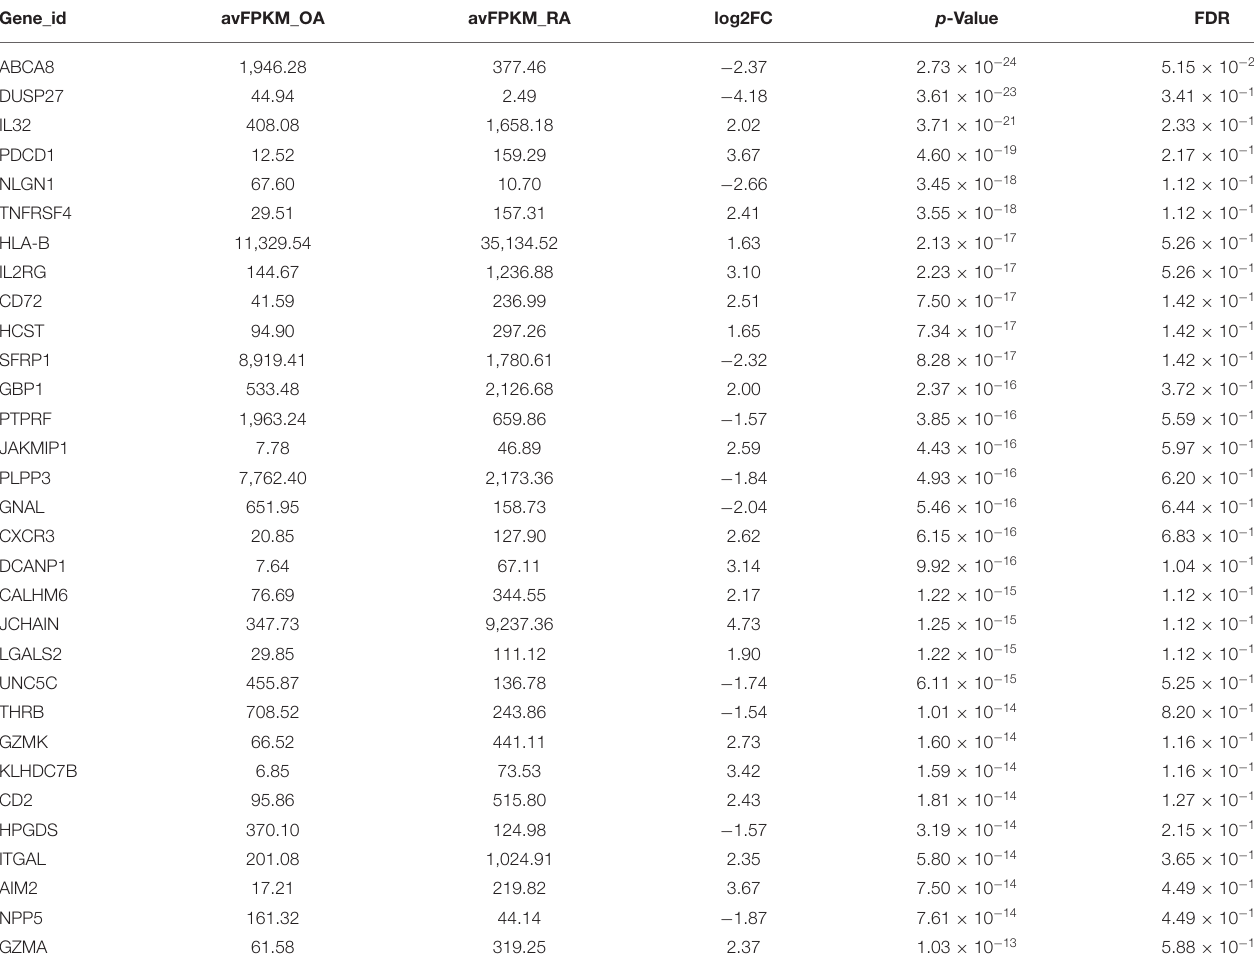
TABLE 2 | Information of the top 30 differentially expressed genes